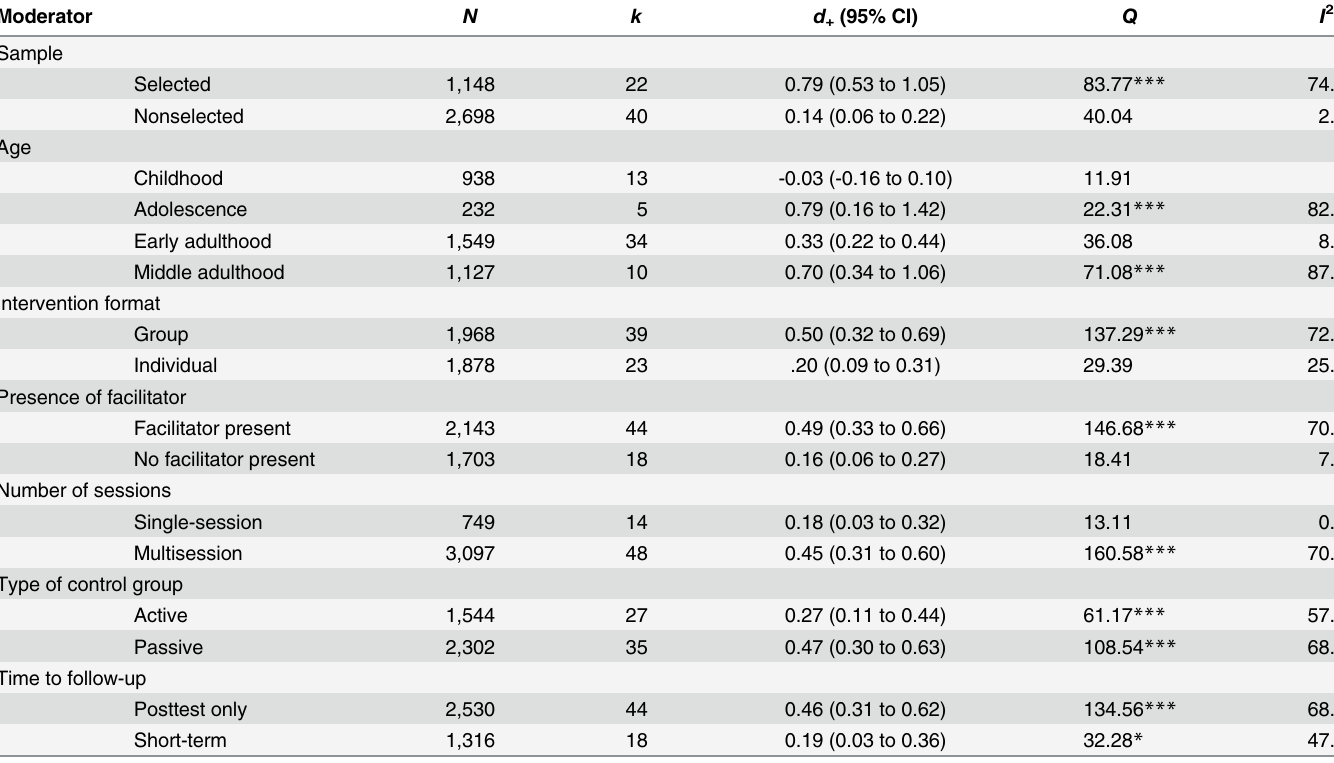
Table 6. Moderators of Intervention Effects on Body